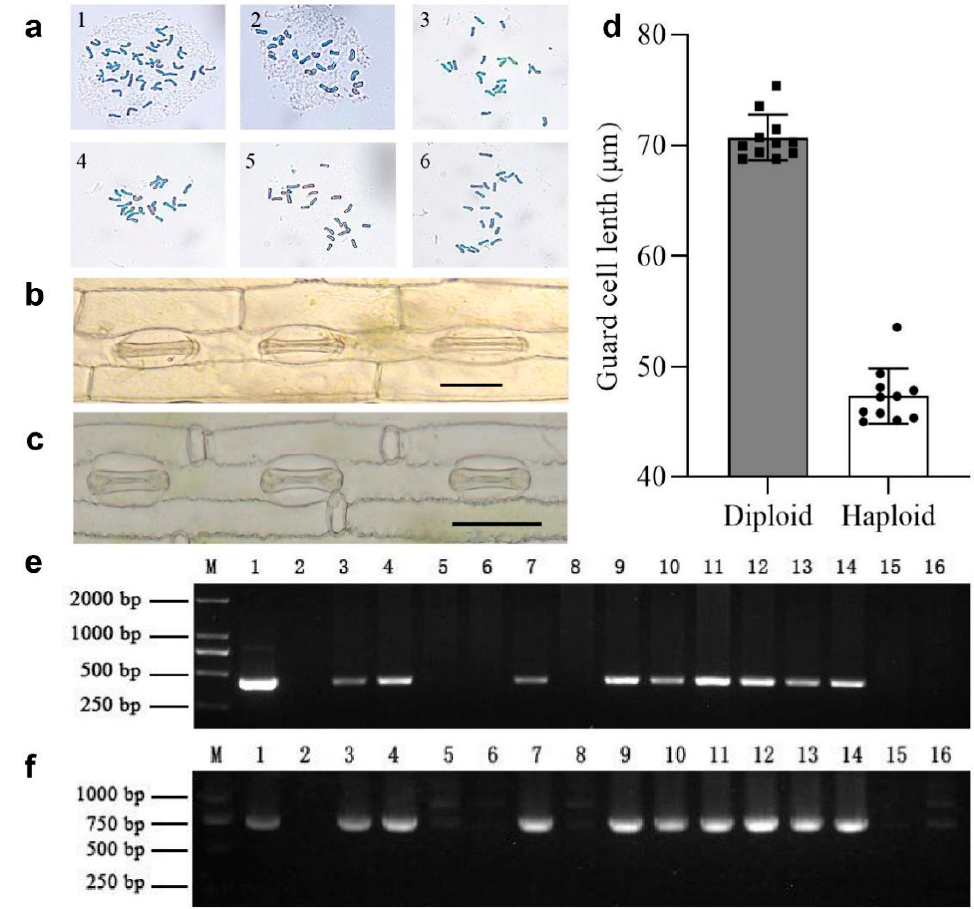
Figure 1. Identification of wheat haploid plants in the mtl progenies. ( a1 ) Diploid plants with 42 chromosomes; ( a2 – a6 ) Haploid plants with 21 chromosomes; ( b ) Guard cells of diploid plants, scale bar = 50 μ m; ( c ) Guard cells of haploid plants, scale bar = 50 μ m; ( d ) The guard cell length of diploid and haploid plants, in which the square and round represented individual data point of diploid and haploid plants, respectively; ( e , f ) Specific amplifying products of F 1 hybrids, M: DL2000 DNA marker; ( e1 , f1 ): Positive control plants containing bar and Cas9 genes; ( e2 , f2 ): Fieder (negative control); ( e3 – e16 ): and ( f3 – f16 ): F 1 hybrids of Fieder × mtl mutants (the specific bands of bar and Cas9 genes were amplified in diploid samples not in haploid samples). Table 2. Wheat seed setting rate, haploid induction rate, and embryoless grain analysis in the self- and cross-pollinated combinations of the mtl